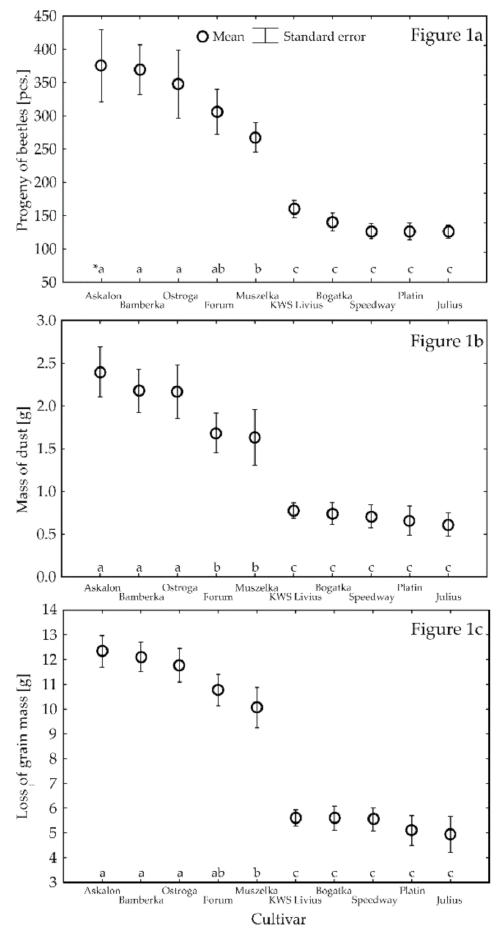
Figure 1. The average number of progeny beetles of S. granarius ( a ), the mass of produced dust ( b ), and the grain mass loss ( c ) observed on the grain of the studied wheat cultivars (* means followed by the same letter do not differ—Tukey’s HSD